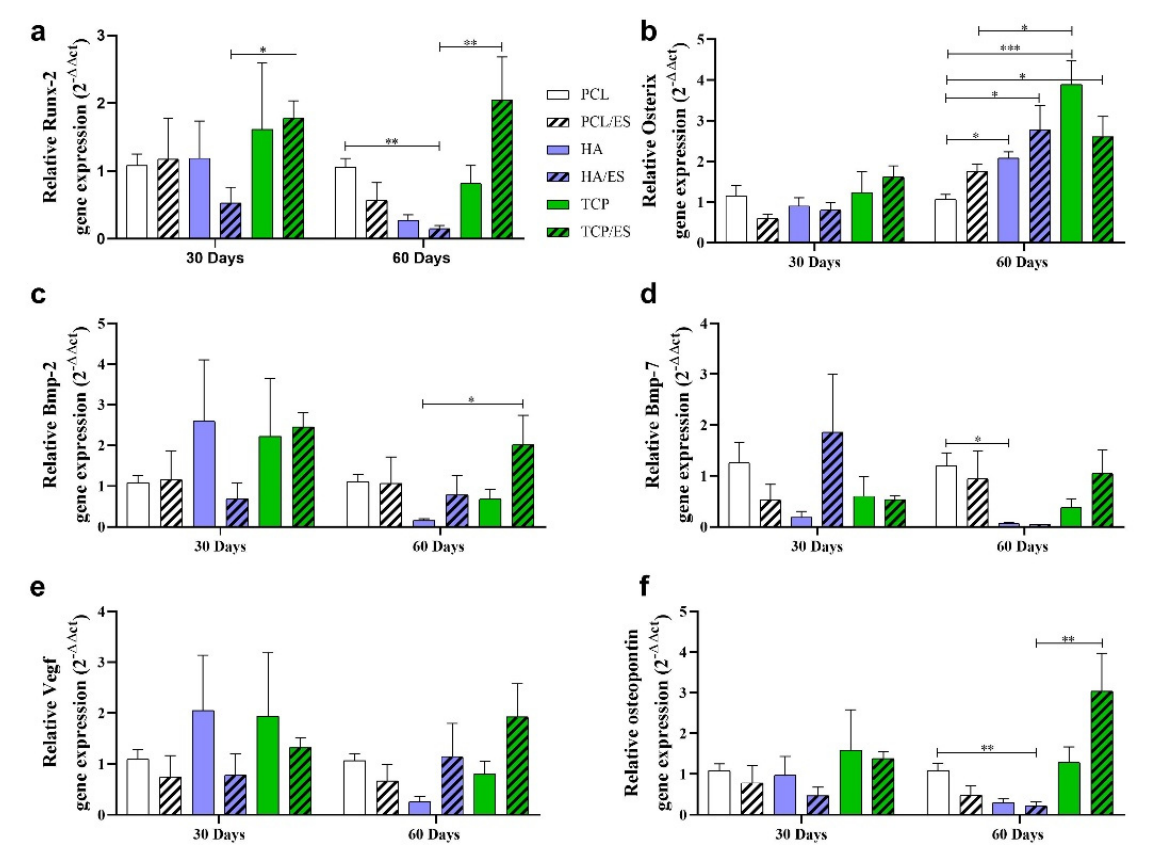
Figure 5. Gene expression showing the relative fold change for ( a ) Runx-2; ( b ) Osterix; ( c ) Bmp-2; ( d ) Bmp-7; ( e ) Vegf; and ( f ) Osteopontin. * ( p < 0.05); ** ( p < 0.01); *** ( p < 0.001). Figure 5b show the relative expression of Osterix. All groups displayed a similarly low expression after 30 d. However, on day 60, in the groups with HA and TCP particles, the Osterix gene expression increased, and the TCP group showed statistically higher relative expression compared to the PCL (3.5-fold change) and PCL/ES (2-fold change) groups. It can also be observed that the TCP/ES, HA/ES, and HA groups presented higher expression (2.5-fold change) than the PCL group. Figure 5c show the relative Bmp-2 gene expression. On day 30, the HA, TCP, and TCP/ES groups showed higher expression, even without significant evidence. On day 60, the TCP/ES group presented higher expression compared to the HA/ES group and twice as high as the PCL group. Figure 5d show the relative Bmp-7 gene expression. The HA/ES group showed higher expression than the other groups at day 30. On day 60, HA and HA/ES showed significantly lower Bmp-7 expression than the other groups. Figure 5e show that on day 30, the HA and TCP groups presented higher expression of Vgef than the other groups; however, there was no significant difference. The same was observed on day 60 for the HA/ES and TCP/ES groups. Figure 5f show the relative expression of OPN. On day 30, all groups showed similar expression. However, on day 60, the TCP/ES and PCL groups showed higher expression than HA/ES. For TCP/ES, expression was three times higher than the